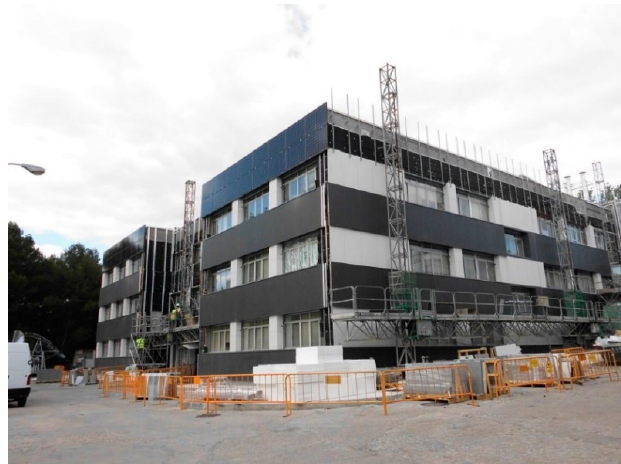
Figure 3. Southwest view of the rehabilitation works.